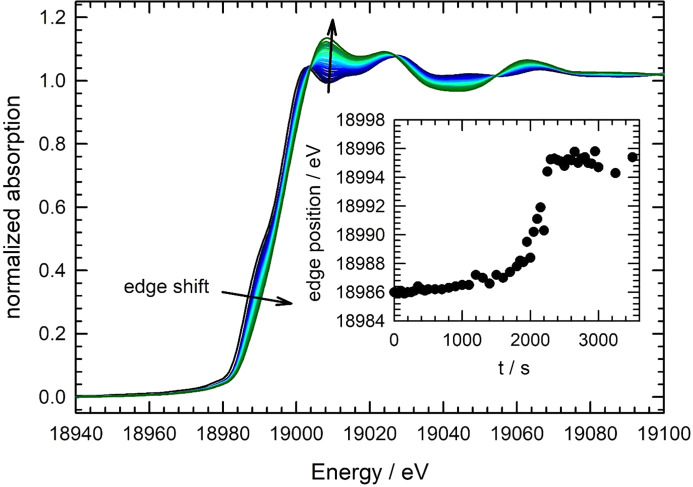
Time-resolved X-ray absorption near-edge spectra (XANES) measured at P64 during the exposure of an Nb thin foil (8 µm thickness) to an air-atmosphere of 10−3 mbar at 900°C. The displayed spectra were recorded with 0.5 s per scan (1 Hz), and one spectrum is displayed every three minutes (colour code from dark blue to dark green with increasing time). In the inset, the shift of the absorption edge defined as the first inflection point of the spectrum is shown.